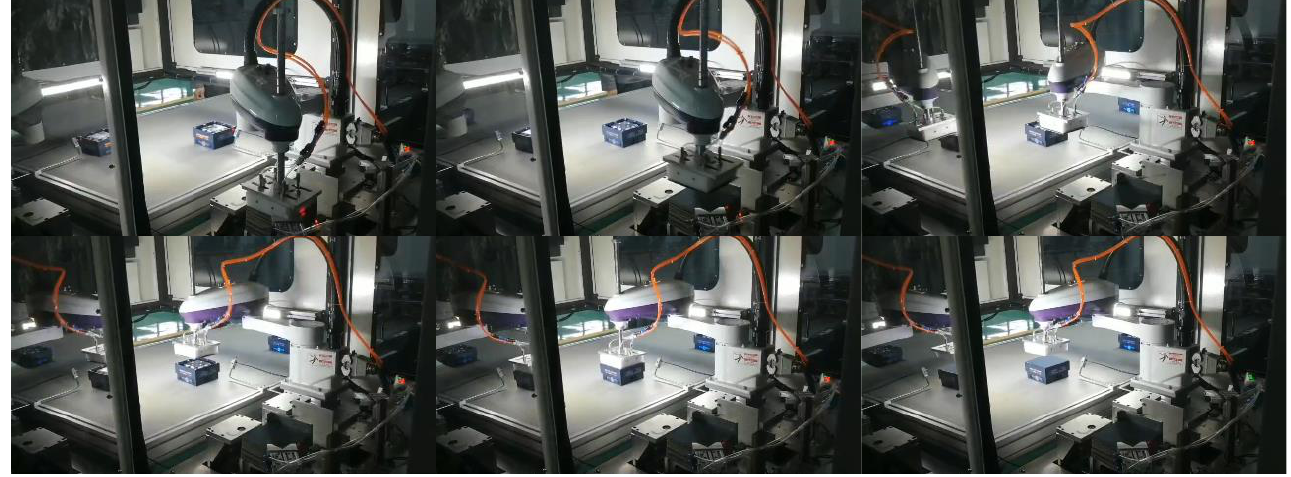
Figure 8. The specific action process of the SCARA robot.